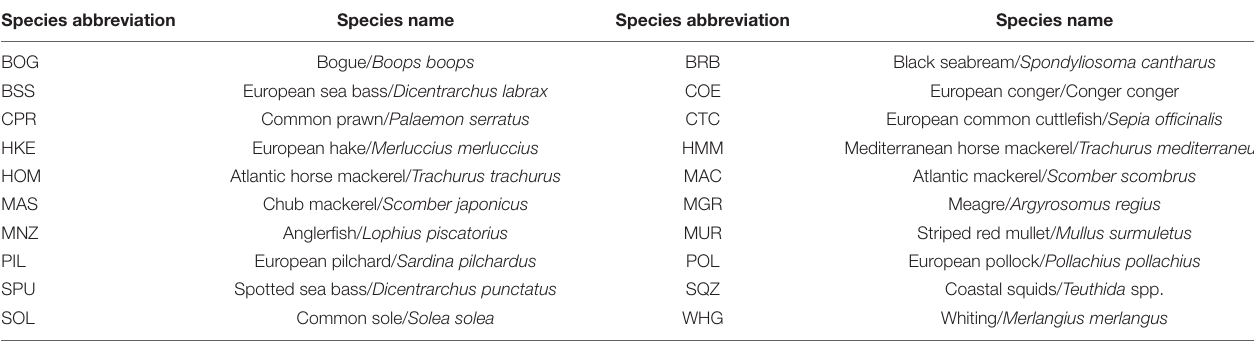
TABLE 2 | Caught fish species included in the study and their ICES